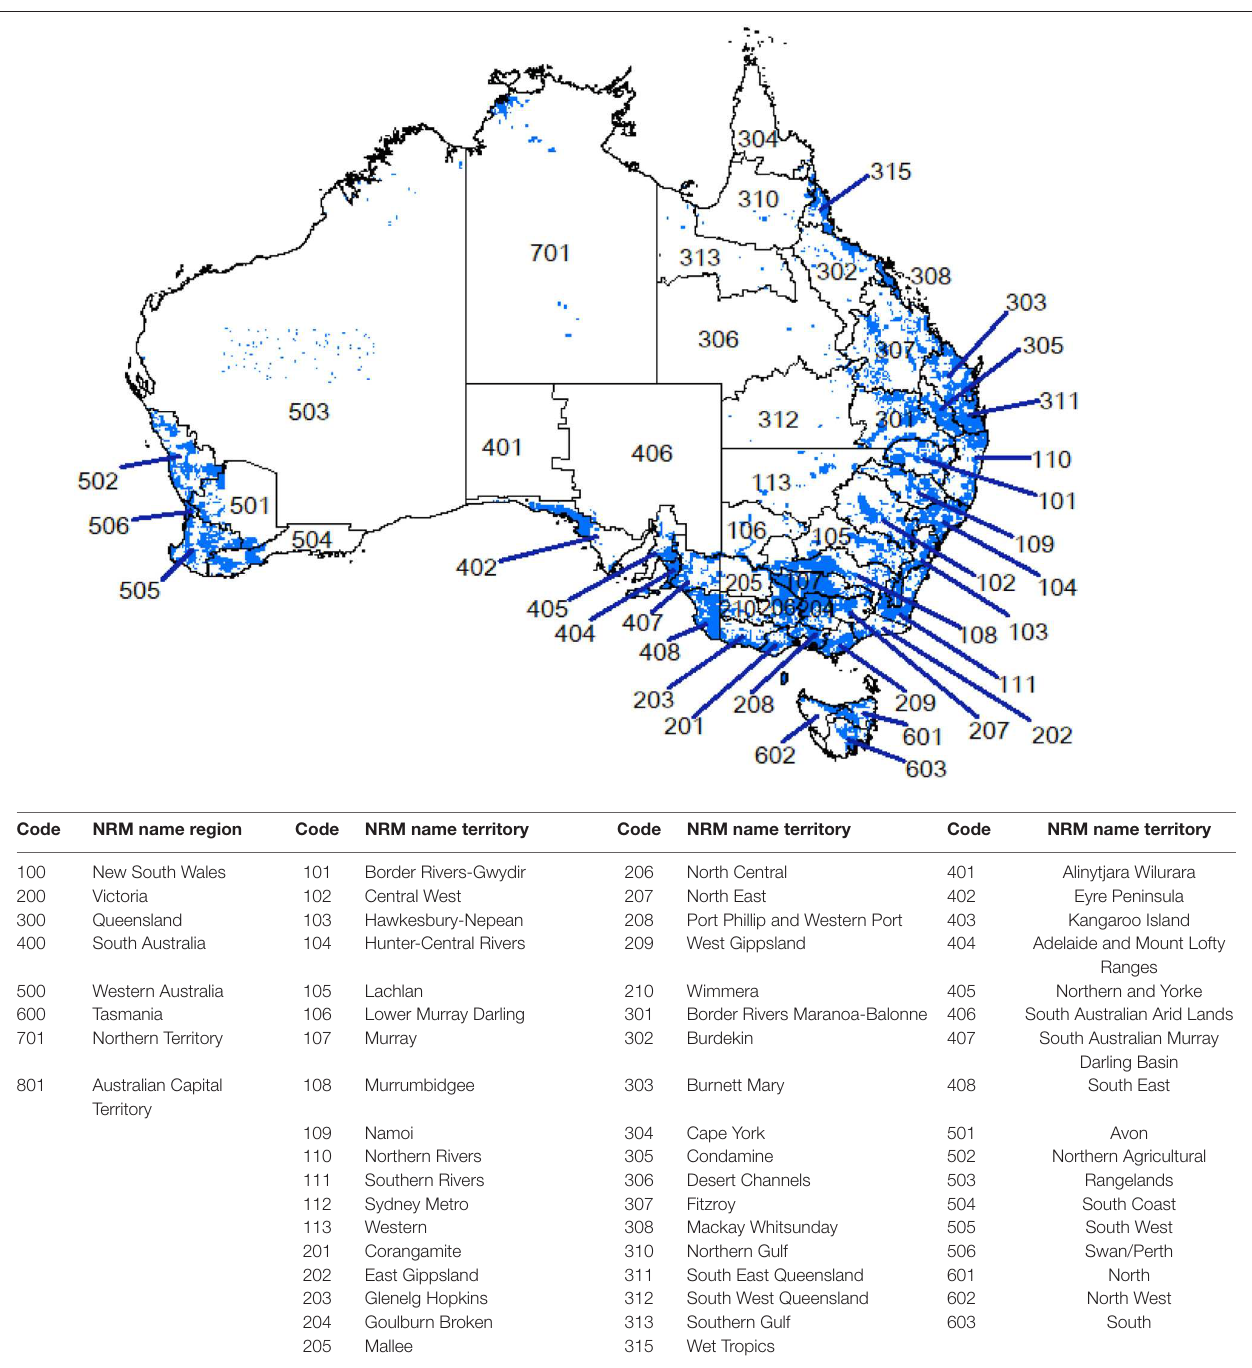
and 20 years for infrastructure and equipment,